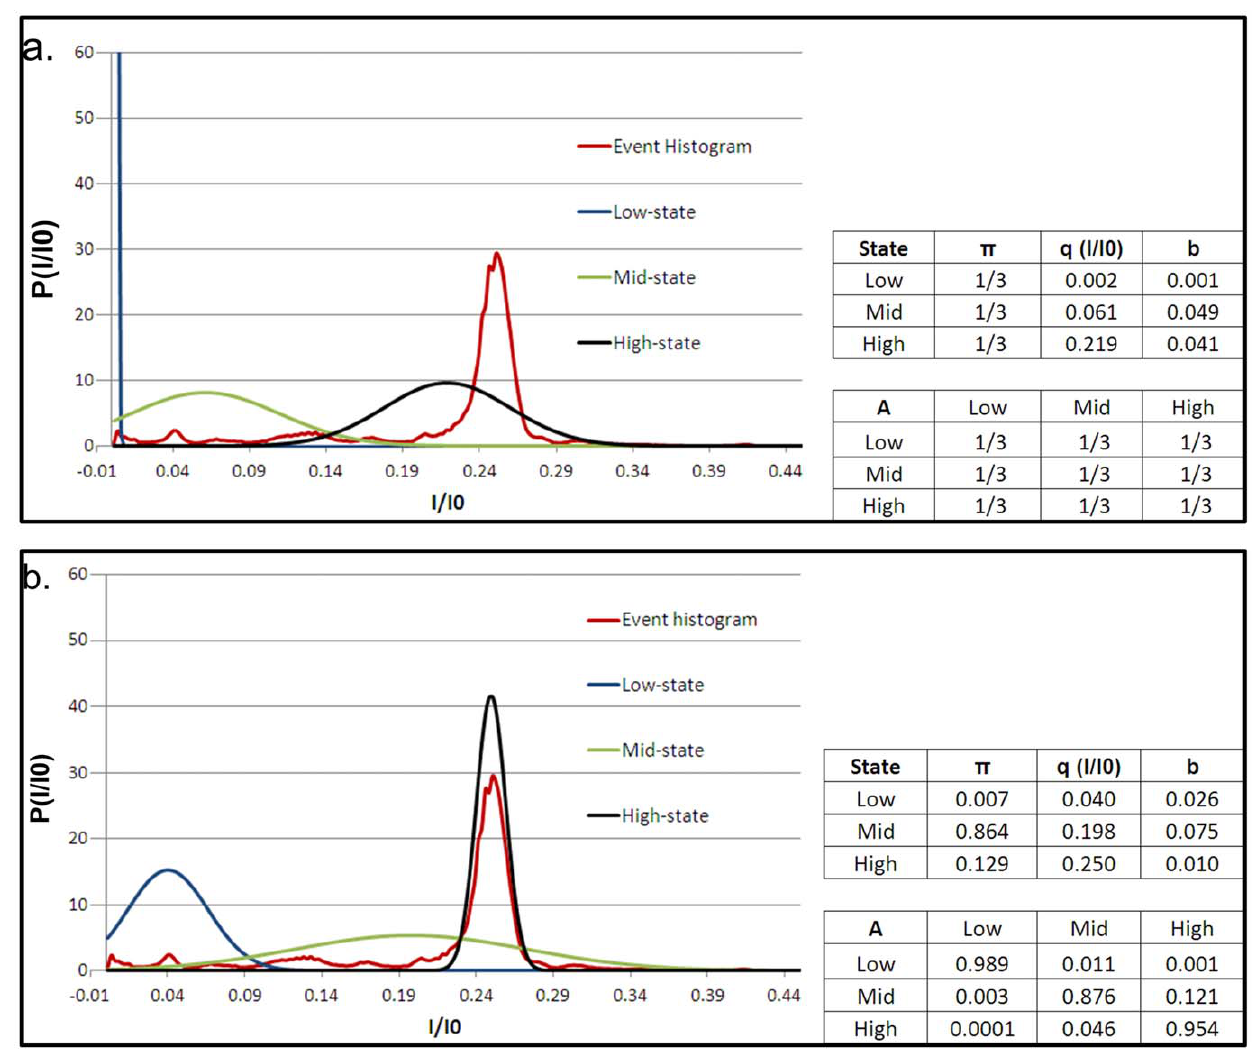
Figure 5. KKRR-ShPrP(120–232)-D178N event histogram and initial and optimal HMM models. ( a ) (Left) The KKRR-ShPrP(120–232)- D178N event histogram (red), and the corresponding high-state (black), mid-state (green) and low-state (blue) that make up the initial model for HMM analysis. The location of the peak ( q ) and width of the distribution ( b ) for each state are the same as for the optimal KKRR-ShPrP(120–232) model (Figure 4B). This choice for q and b serves to highlight how the individual states evolve and differ from that of wild-type PrP C . (Right) The corresponding initial model parameters. Similar to the initial model for KKRR-ShPrP(120–232) (Figure 4A) we assume ignorance of the probabilities and therefore assume p to be uniformly distributed. Likewise, with the transition probability matrix ( A ), we assume all transitions to be equally likely. ( b ) (Left) After 36 iterations of the EM algorithm the optimal three-state model that best describes the data (i.e. the maximum likelihood model estimate) is converged upon. The individual states (properties and kinetics) are significantly different from wild-type PrP C (Figure 4B), highlighting the importance of amino-acid residue D178 to the dynamics and structural stability of PrP C (Right) The corresponding optimal model parameters. doi:10.1371/journal.pone.0054982.g005 been previously applied in characterizing the complex kinetics of DNA hairpins trapped in the a -HL nanopore [39,40]. HMM analysis requires an initial model for the system defined by the following parameters: State levels in terms of I/I0 ( q ), the initial condition ( p ) (i.e. the probability that an event begins in a given state), the transition probabilities between states ( A ), and the noise properties (the standard deviation on a Gaussian) of each state ( b ). These parameters represent best guesses and can be estimated, with respect to q and b , from the event histogram. Once the initial model is developed and provided with the corresponding data, the HMM operates through an expectation maximization (EM) algorithm improving upon the model parameters with each iteration until convergence to an optimal set of parameters that